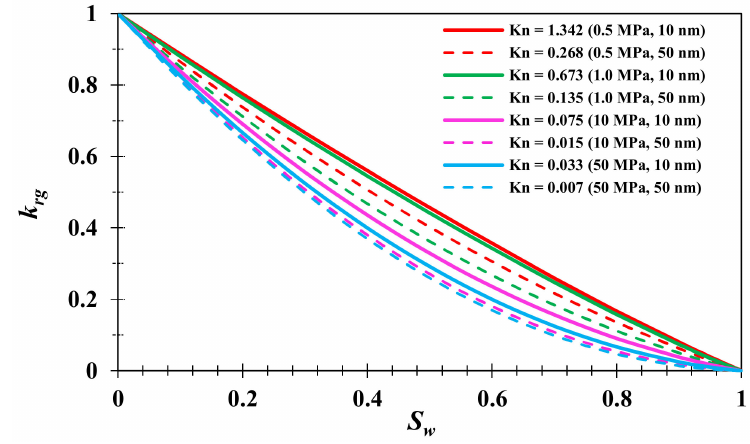
Figure 13. Relative permeability curves with different Knudsen numbers (slit pore).